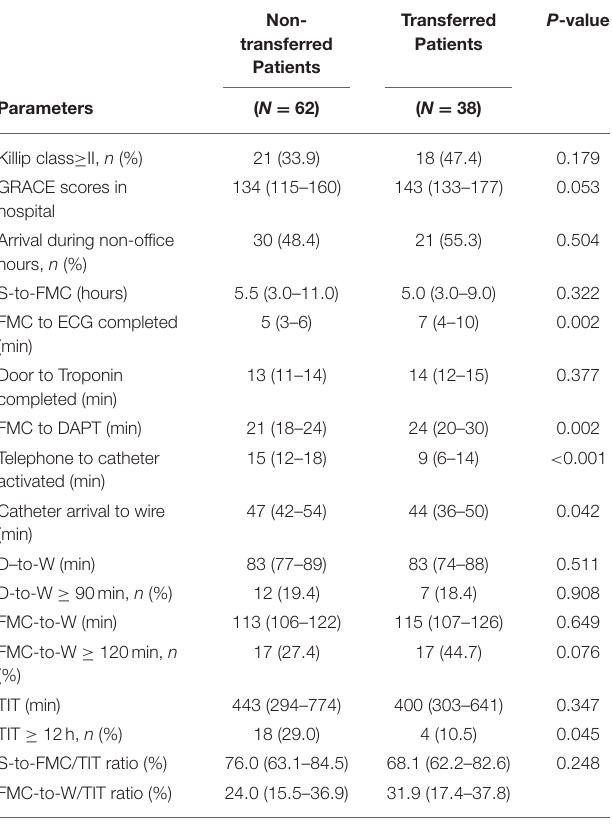
TABLE 4 | Comparison of parameters between timely PPCI and delayed PPCI during COVID-19 pandemic. P -value Non- Transferred transferred Patients Patients